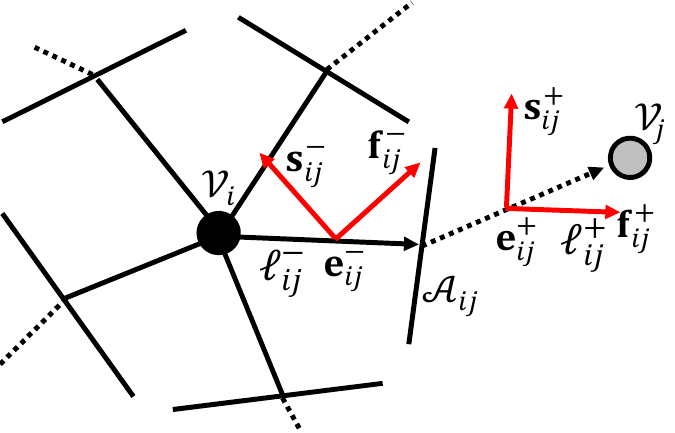
Figure A3. Components of a generic network node–edge–node connection. The network discrete monodomain equations described by Equations (A4)–(A6) were implemented in custom-written code, which was parallelized and tuned for both memory and computational efficiency.